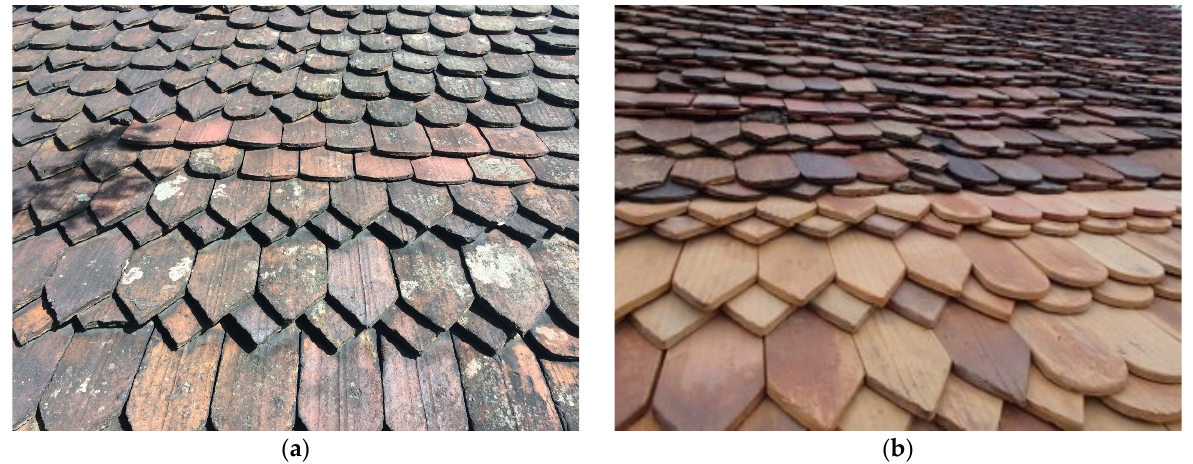
Figure 14. Different types of roof tiles: ( a ) historical; ( b) new roof tiles in historic dimensions. It was also found that on the south slope, the tiles were laid in a scalloped pattern (on the north slope in a lace pattern) with lime mortar fixings with fur and the joints sealed with wooden